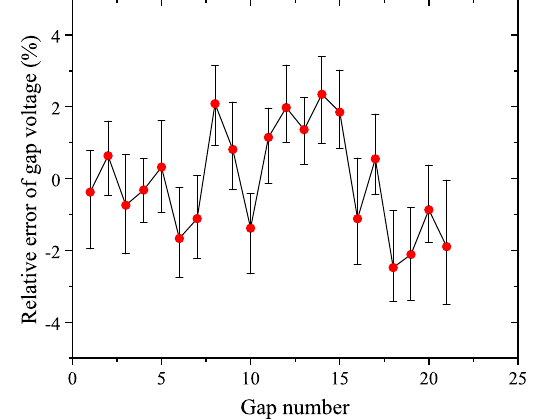
FIG. 7. Relative error in gap voltage after tuning with copper